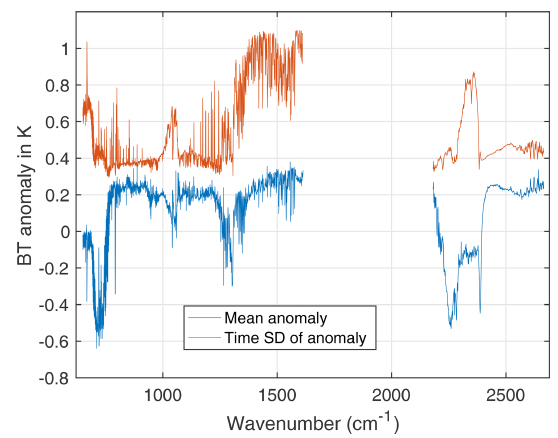
Figure 3. Mean BT trends ( a 1 in Eq. 1) averaged over ± 50 ◦ in (cid:49) BTyr − 1 units. The 2 σ uncertainty shown has been corrected for serial correlations in the BT time series. Channels used in the anomaly retrievals are denoted in red, and the BT trend uncertainty is in yellow.